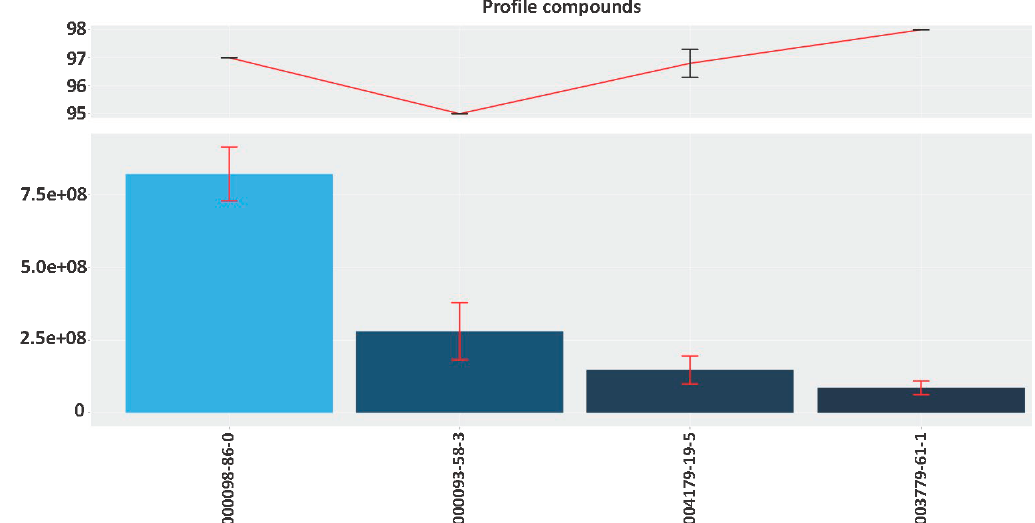
Figure 2. plotGroup function. This graph shows the constitutive profile by frequency of the wild-type snapdragon at ZT9 (Zeitgeber time). The x-axis shows the CAS number of volatile organic compounds. The upper part displays the average quality of volatiles (red line) and the lower part of the graph indicates the average areas of compounds (blue bars), that are plotted in decreasing order. Whiskers show the standard deviation of quality (upper part) and area (lower part).